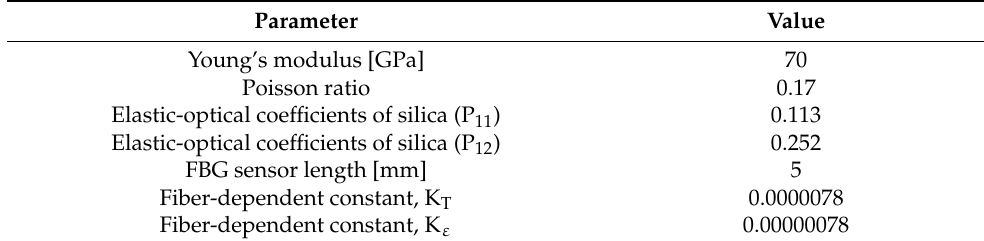
Table 1. Fiber Bragg Grating